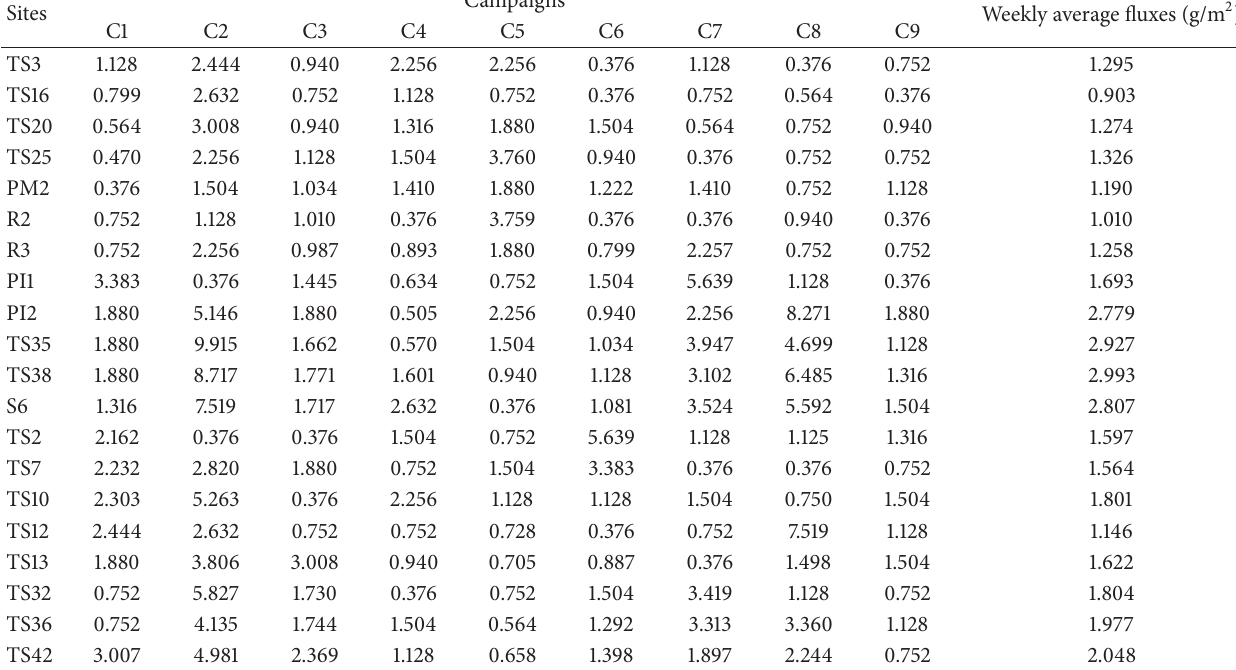
Table 1: Variation of the weekly fluxes (g/m 2 ) of dry particulate fallout during the period of study. Sites